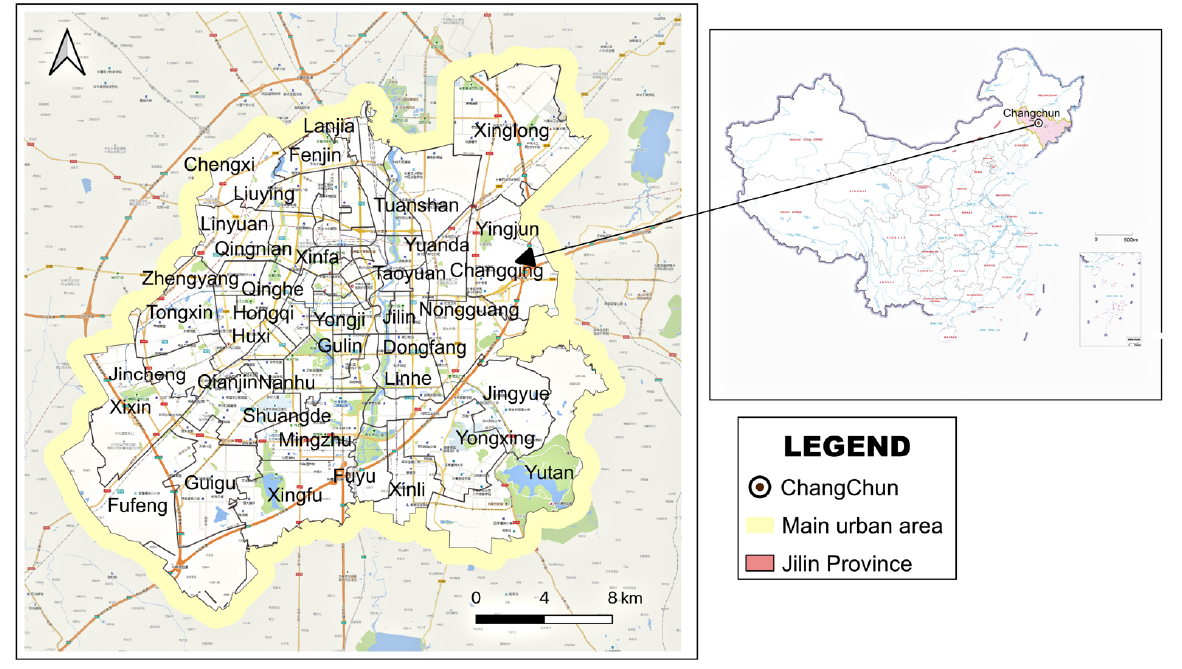
Figure 2. Study area. Source: Ministry of Natural Resources of People’s Republic of China